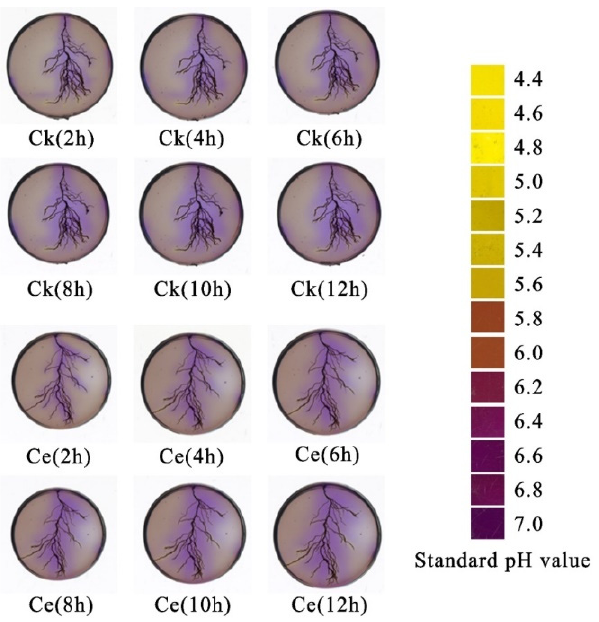
Figure 6. Changes in the rhizosphere pH of P. vittata at different time points. Ce, Claroideoglomus etunicatum ; Ck, control.